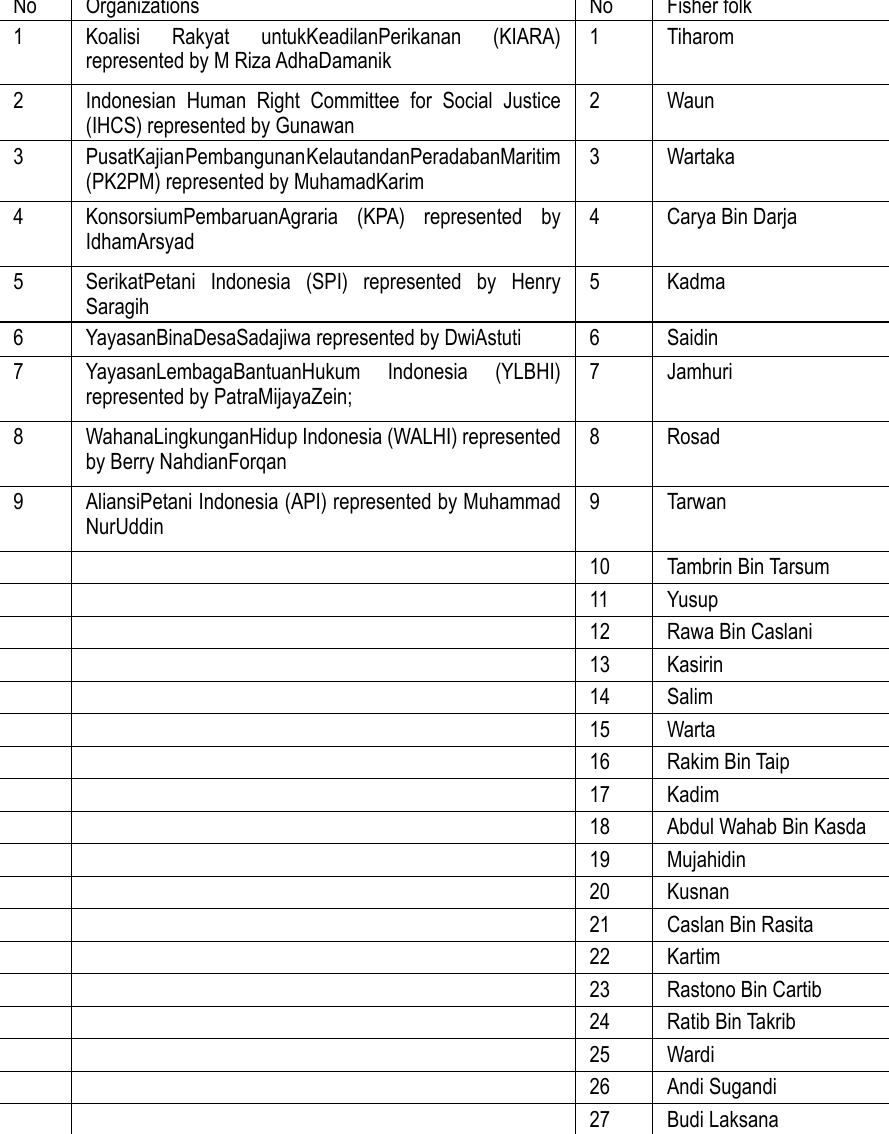
Table 1. List of Petitioners for Judicial Review of Law Number 27 of 2007 No